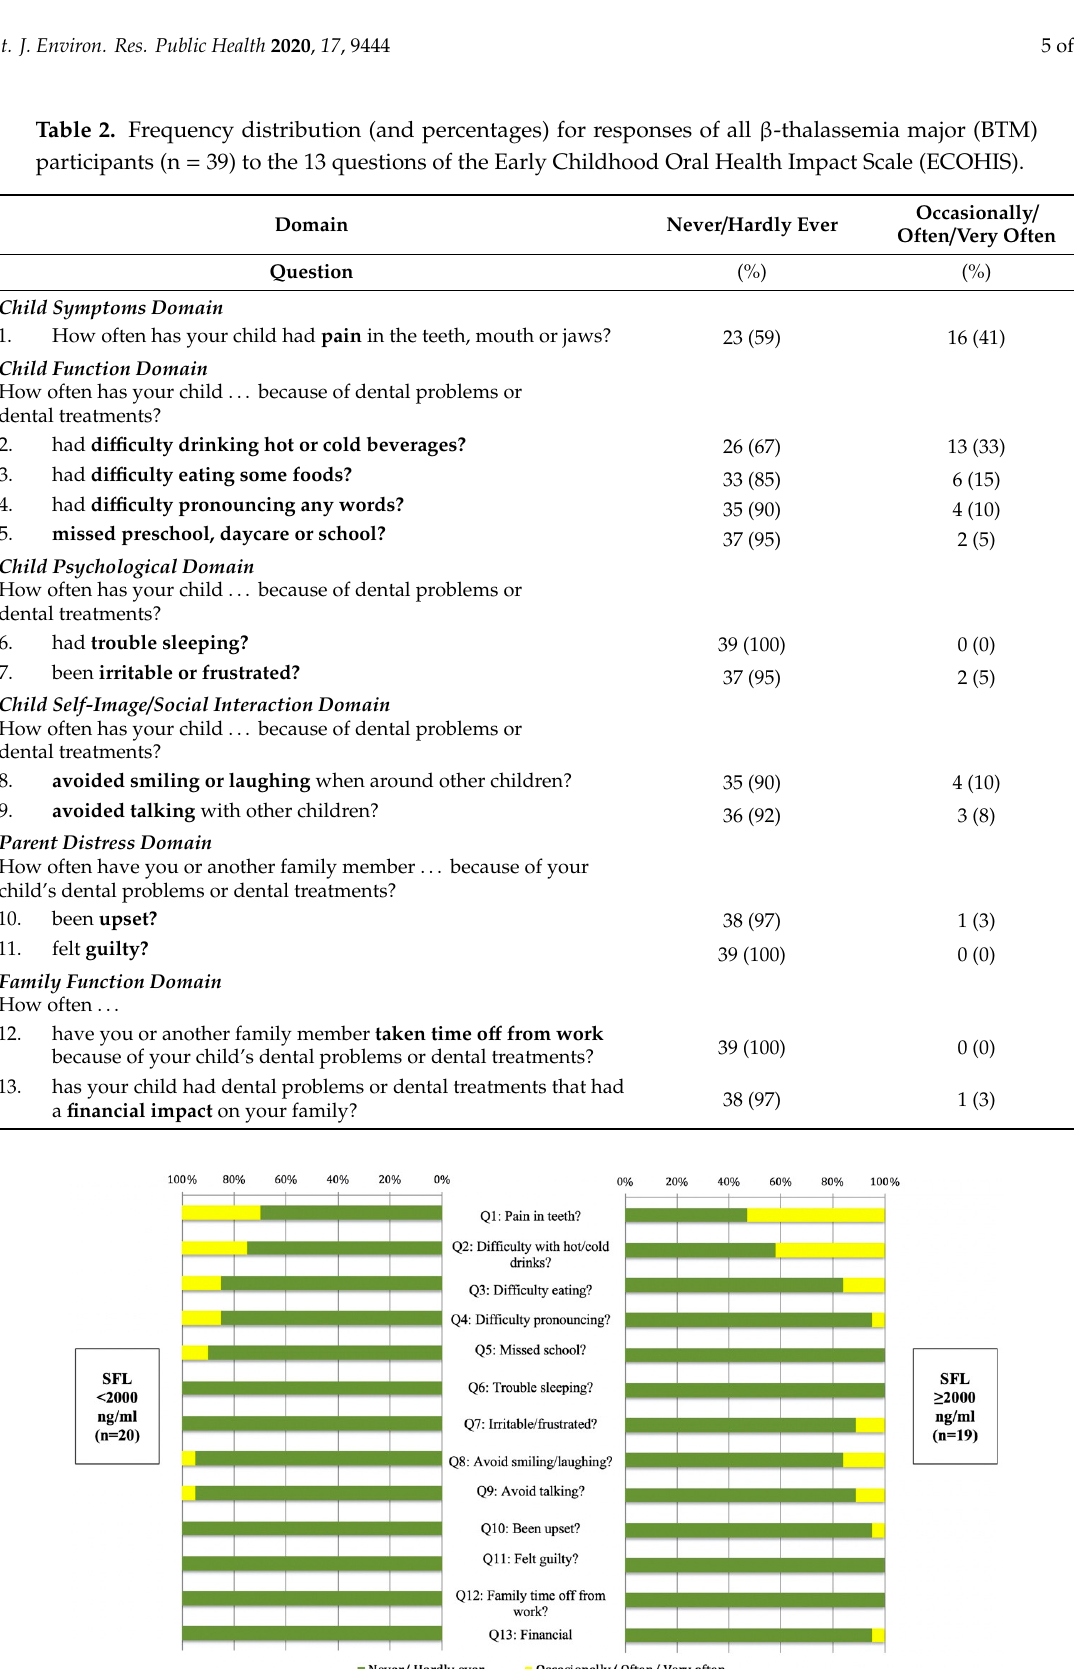
Occasionally / Often / Very Often